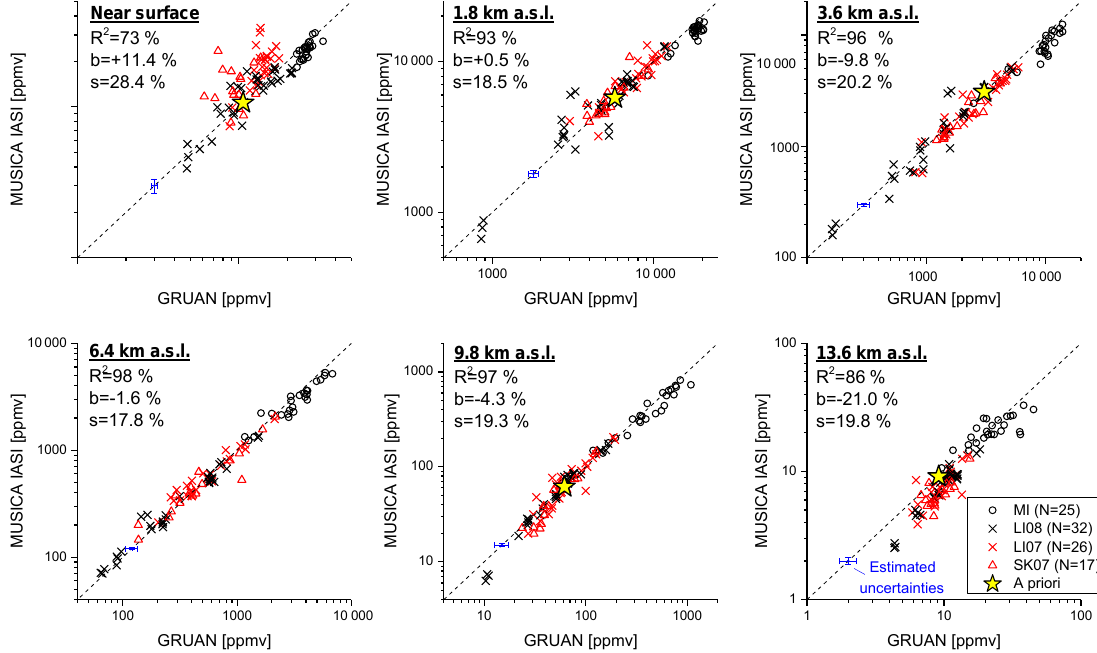
Figure 14. Correlation between GRUAN (along x axes) and MUSICA IASI data (along y axes) for the six different atmospheric altitudes that are highlighted in Figs. 3 and 5. All the presented data are for MUSICA IASI retrievals that use the GRUAN temperature profiles as the a priori atmospheric temperatures. The retrieval altitudes are given in the individual scatter plots, together with correlation coefficient ( R 2 ), bias (b) and scatter (s). Data belonging to the different ensembles can be identified by the symbols and colours as described in the legend (bottom right). The yellow stars represent the a priori value (the retrieval uses the same a priori H 2 O values globally) and the blue error bars indicate the typical GRAUN and IASI errors. The dotted line represents the 1–1